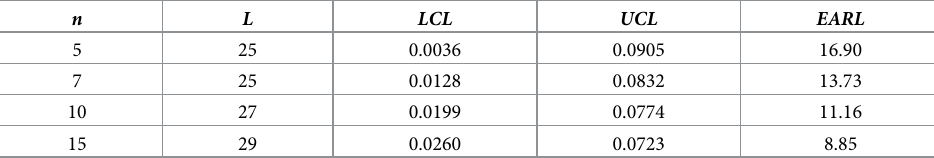
Table 4. Optimal charting parameters and the corresponding EARL values for the EARL -based side sensitive syn- thetic- γ chart for γ 0 = 0.05, n 2 {5,7,10,15} and ( τ min , τ max ) = (1,2]. n L